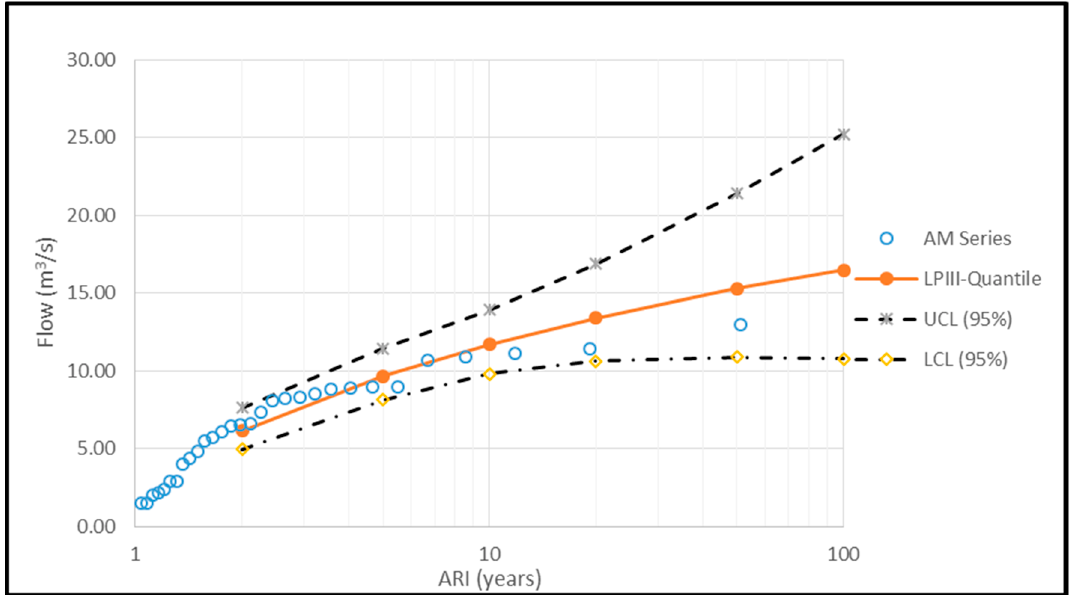
Figure 9. Flood frequency curve (FFC) for the Myponga catchment. ARI: Average Recurrence Interval; AM: Annual Maximum; LP III: Log Pearson Type III; UCL: Upper Confidence Limit; LCL: Lower Confidence Limit.